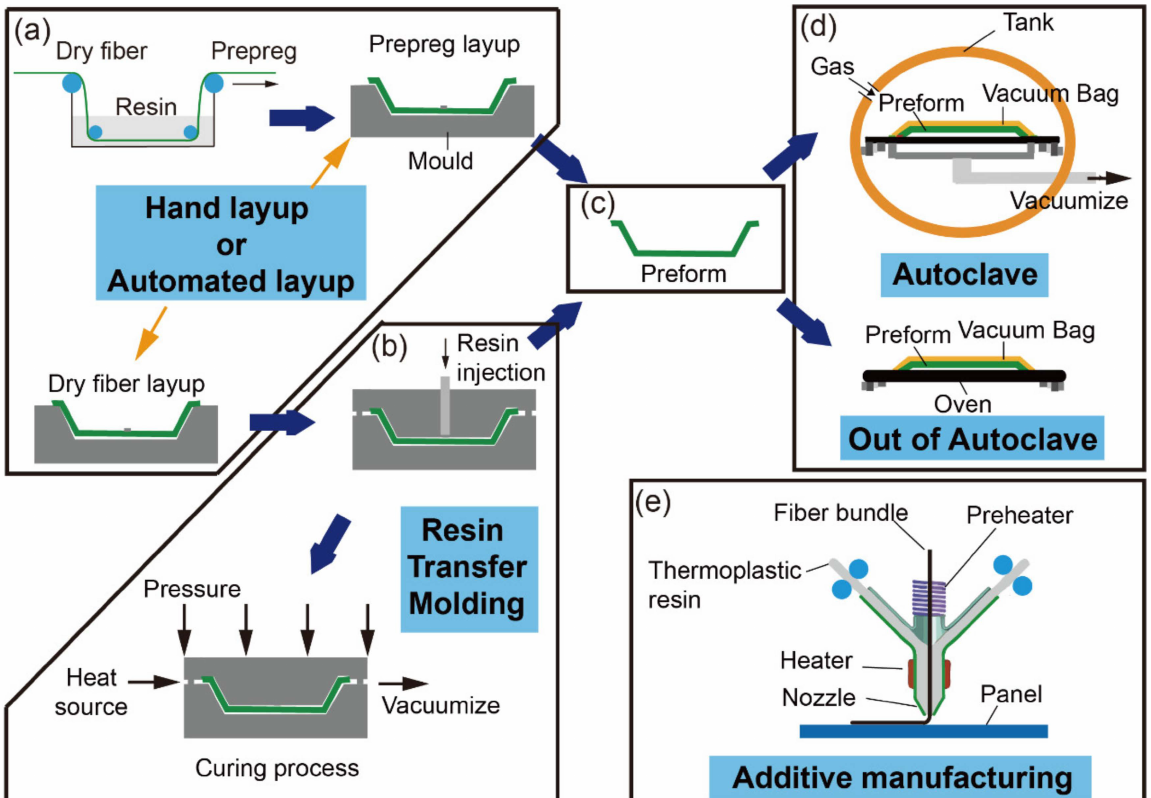
Figure 1. Main manufacturing technologies for continuous fiber-reinforced composite structures: ( a ) Hand layup and automated layup with dry fibers or prepreg; ( b ) RTM technology including resin injection and preform curing process; ( c ) A preform waiting for curing; ( d ) Autoclave and OoA curing process; and ( e ) Additive manufacturing with in situ